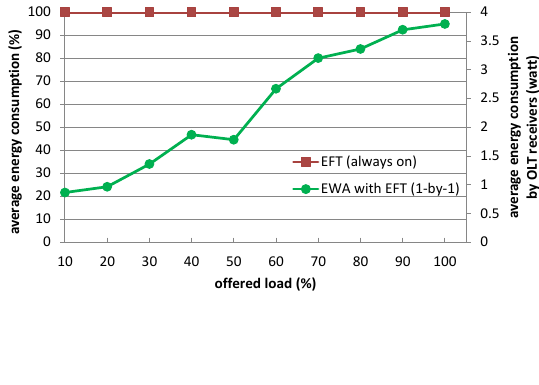
Figure 7. Energy Consumption.